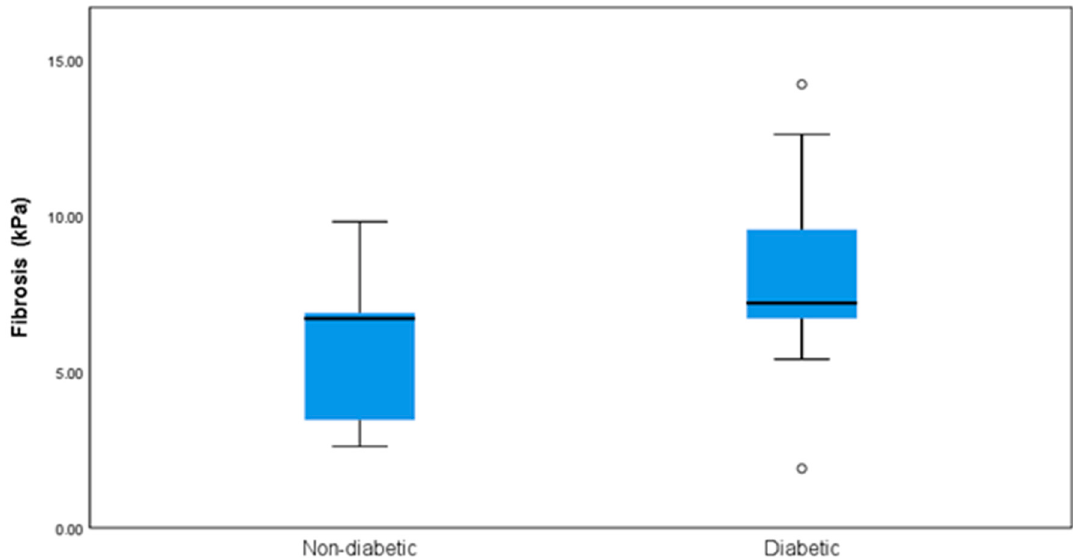
Figure 1. Statistical differences between non-diabetic and diabetic patients regarding the presence of liver fibrosis. Table 2. Vitamin D association between